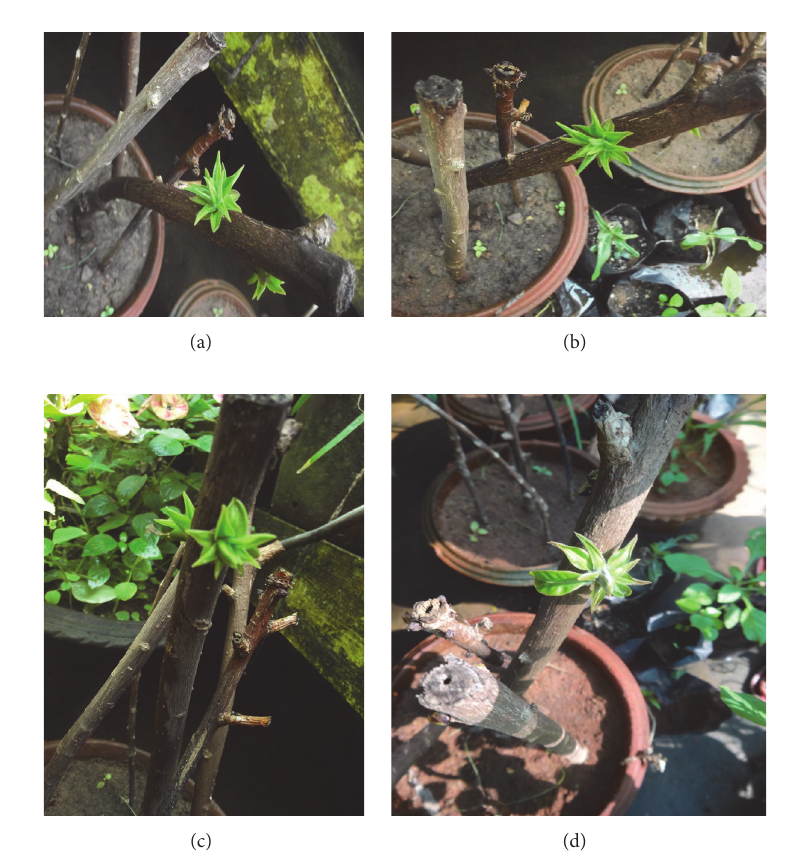
Figure 3: (a), (b), and (d) Different stages in NAA pretreated stem cuttings. (c) IBA treated stem cuttings after 8